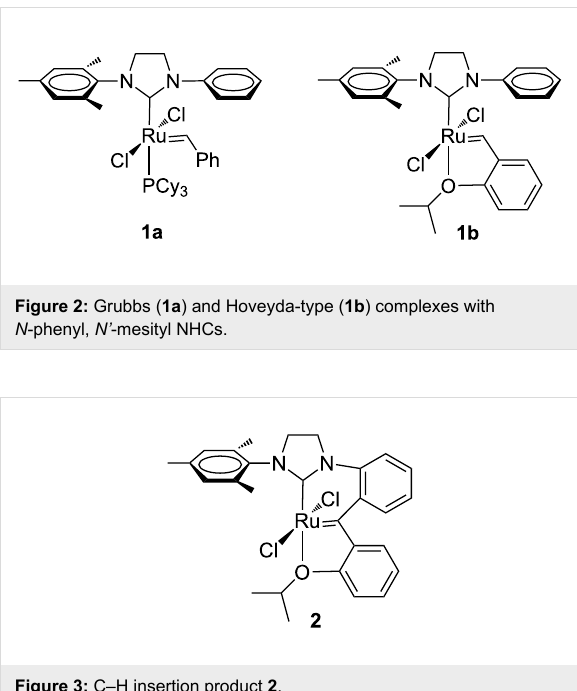
Figure 3: C–H insertion product 2